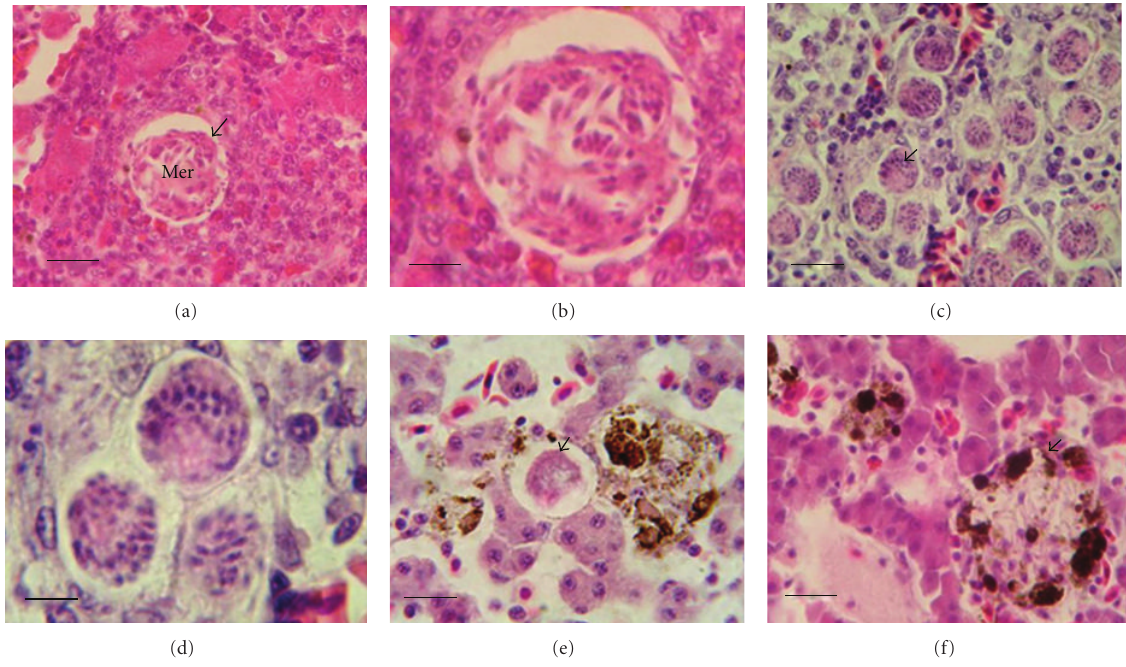
Figure 2: Histopathology findings of the liver tissue of frogs infected with parasites Hepatozoon sp. a, Hepatozoon sp. b, and Lankesterella minima . Meronts (arrowhead in (a), and enlarged version in (b) of Hepatozoon sp. a in liver with evidence of lymphocyte and eosinophil infiltration resembling a granuloma-like lesion (a-b), di ff use multifocal meronts of Hepatozoon sp. b with infiltration by a few inflammatory cells (c-d), meront (arrowhead in (e)) of Lankesterella minima presented in liver, with an increase in melanomacrophages centre (MMCs) and a mild tissue reaction (e), evidence of liver damage associated with a merozoite of Lankesterella minima surrounded by an MMC (f), Mer = meront, haematoxylin-eosin (a, c: Bar = 20 µ m and b, d: Bar = 6 µ m and e, f: Bar = 15 µ